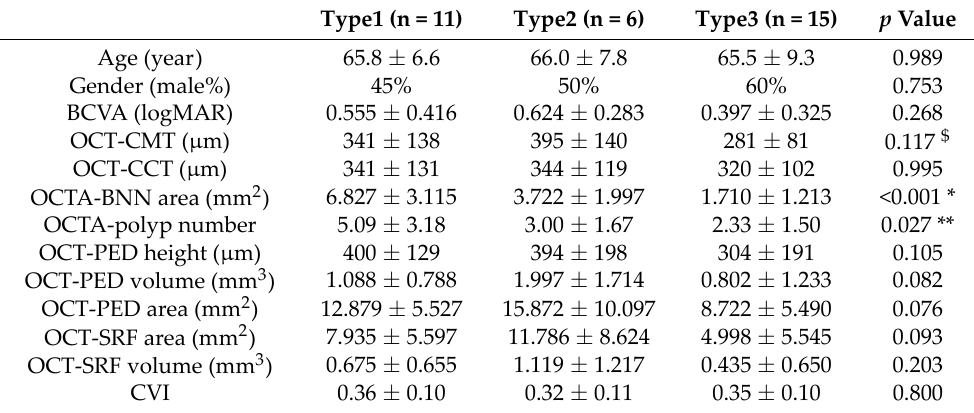
Table 1. Baseline characteristics among 3 PCV